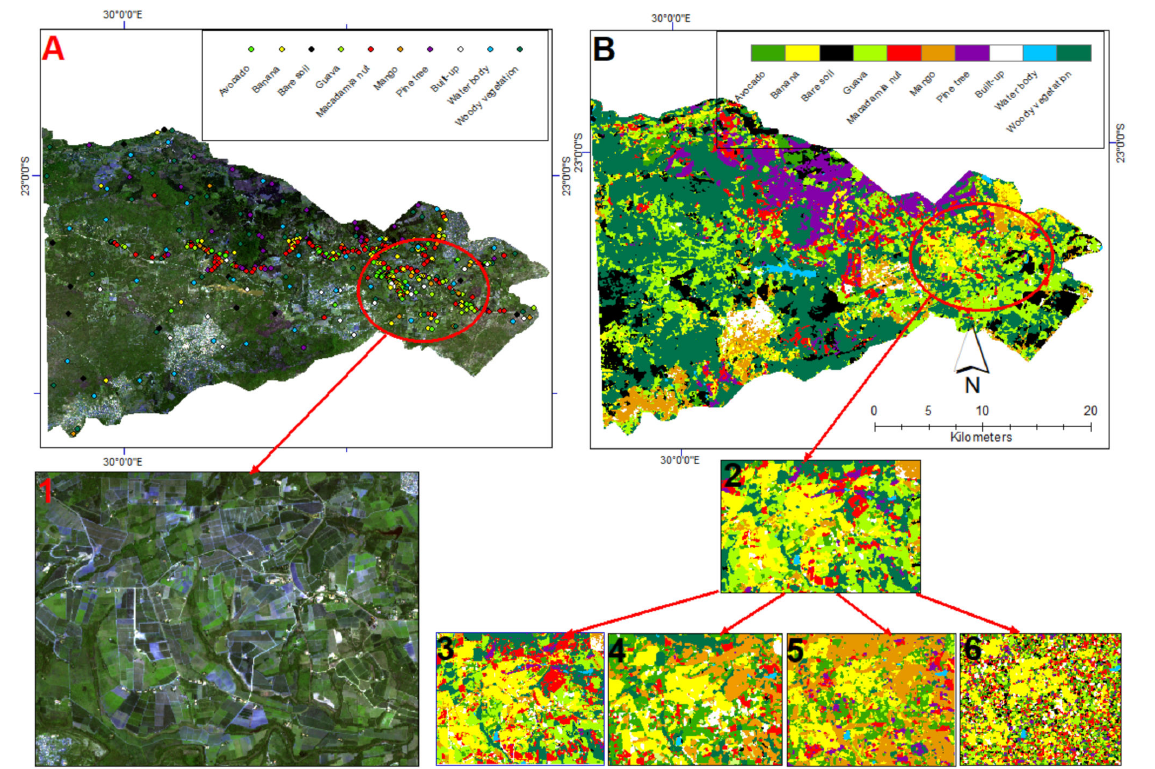
Figure 7. The spatial distribution of fruit-tree crops and co-existing land use types for Levubu subtropical farming area using S1S2 selected variables and SVM, ( B ). ( A ) and zoom-in in ( 1 ) show the unclassified Sentinel-2 RGB image, including the collected ground truth data, respectively. ( 2 – 6 ) show the classified zoom-ins of the same area using different models. In order of merit, these are S1S2 selected variables, S1S2, S2, S2 selected variables and S1.